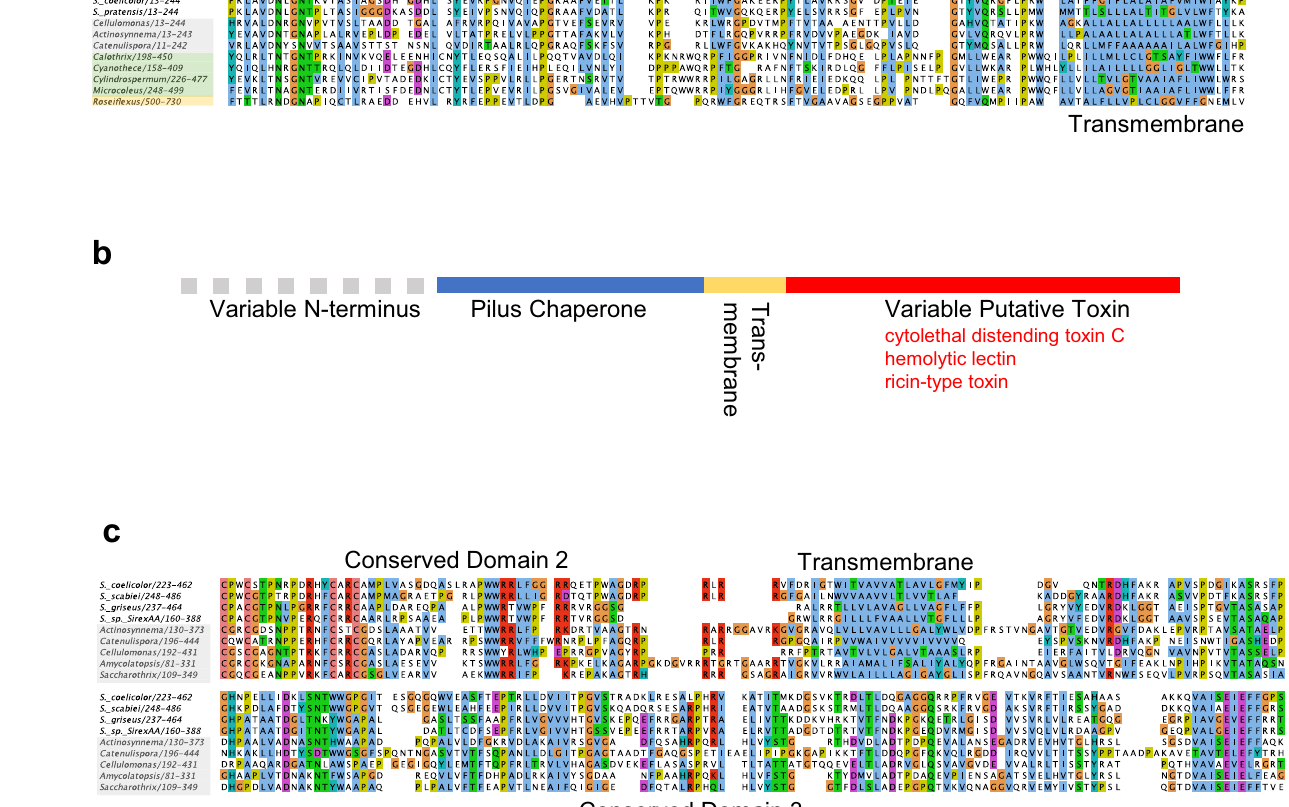
Supplementary Table 3. All Streptomyces strains used were derivatives